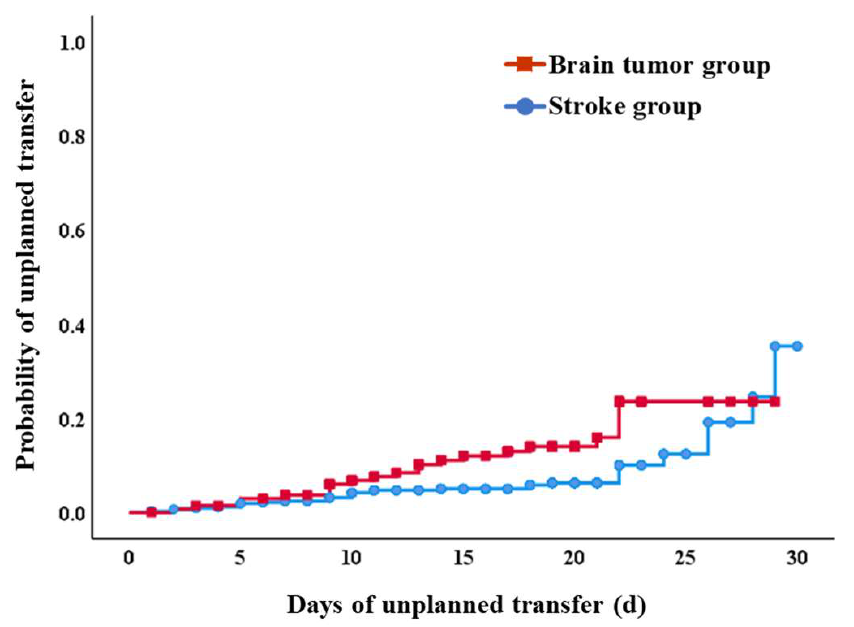
Figure 2. Probability of unplanned transfers in each group (brain tumor or stroke). The Kaplan–Meier regression analyses significantly showed on difference between the two groups in the probability of unplanned transfers during the comprehensive intensive inpatient rehabilitation ( p < 0.05).